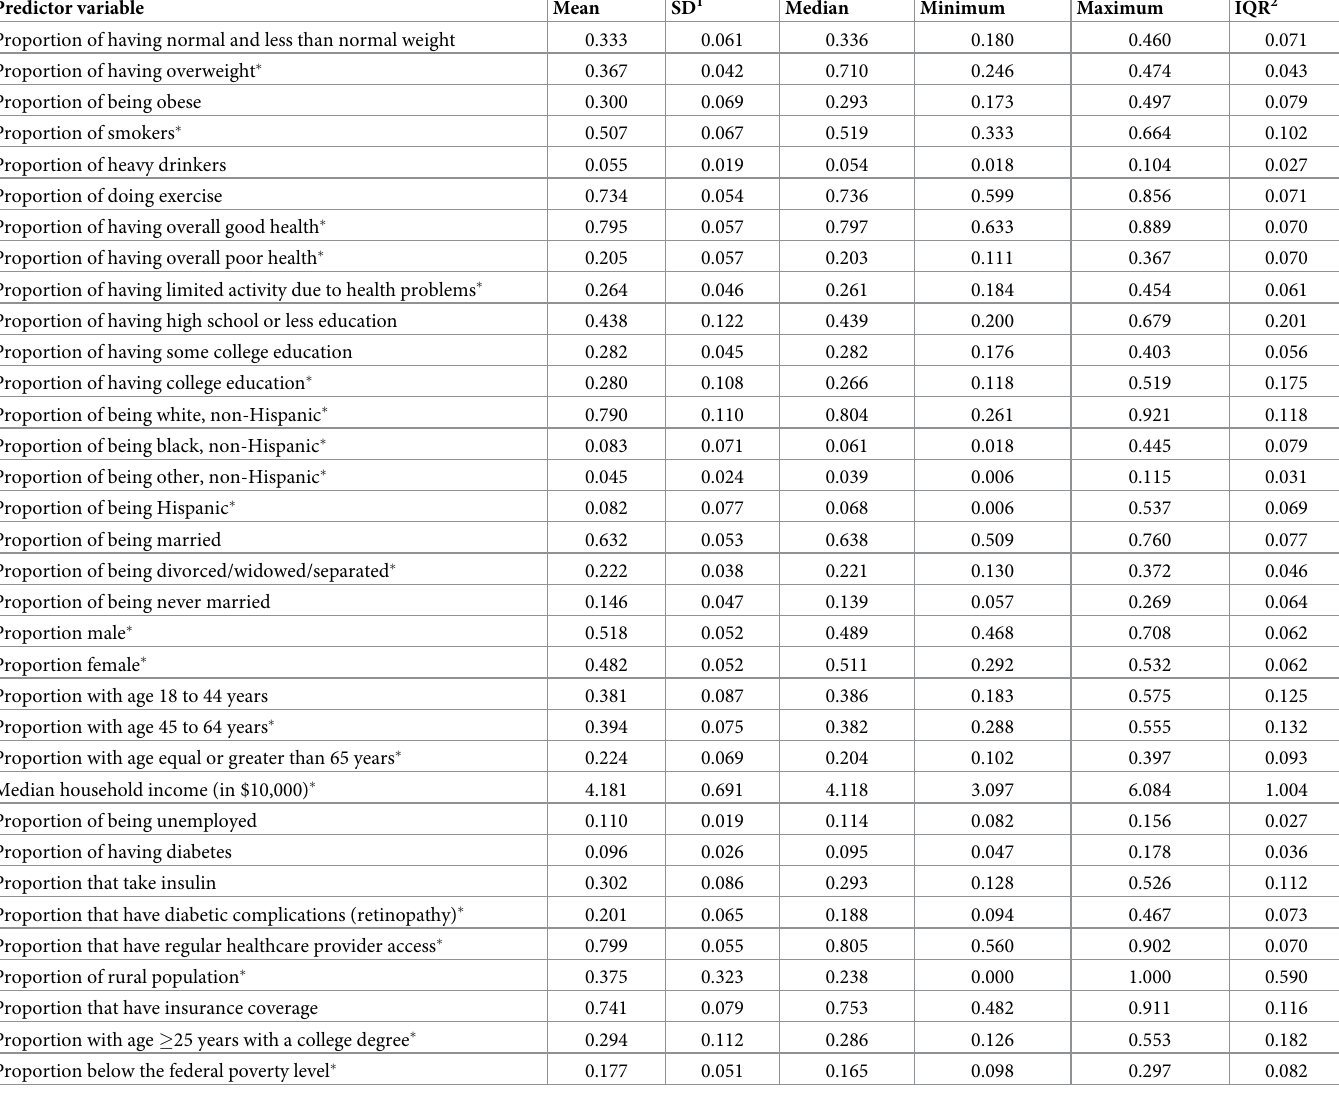
Table 1. Summary statistics of variables considered as potential predictors of county-level Diabetes Self-management Education (DSME) program participation and its hotspots in Florida,